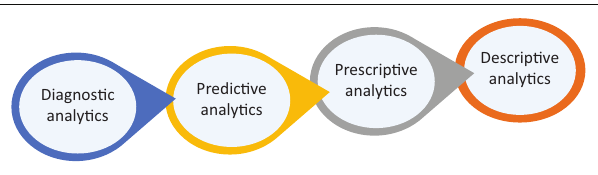
FIGURE 3: Taxonomy of Big Data